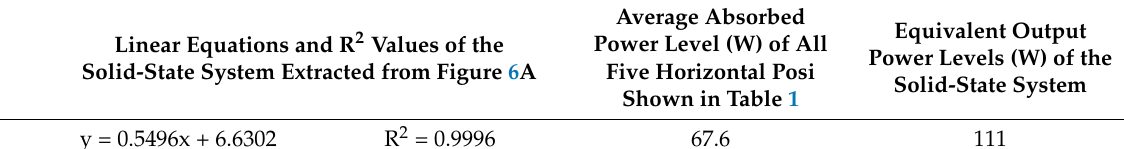
Table 2. Parallel output power levels for absorbed power level of 67.6 W in the vertical orientations in the solid-state microwave system.